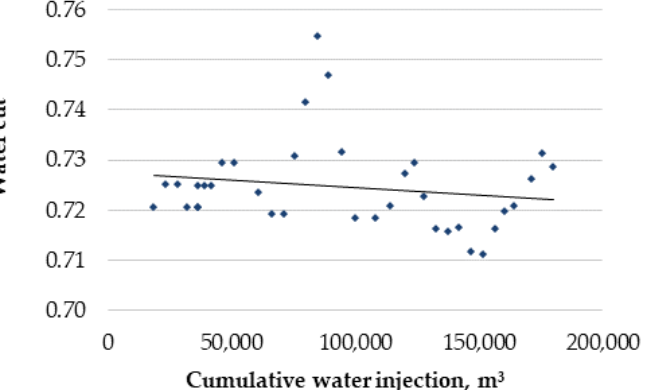
Figure 7. Dependence of water cut of well No. 13G on volume of injected water through injection well No. 1006.